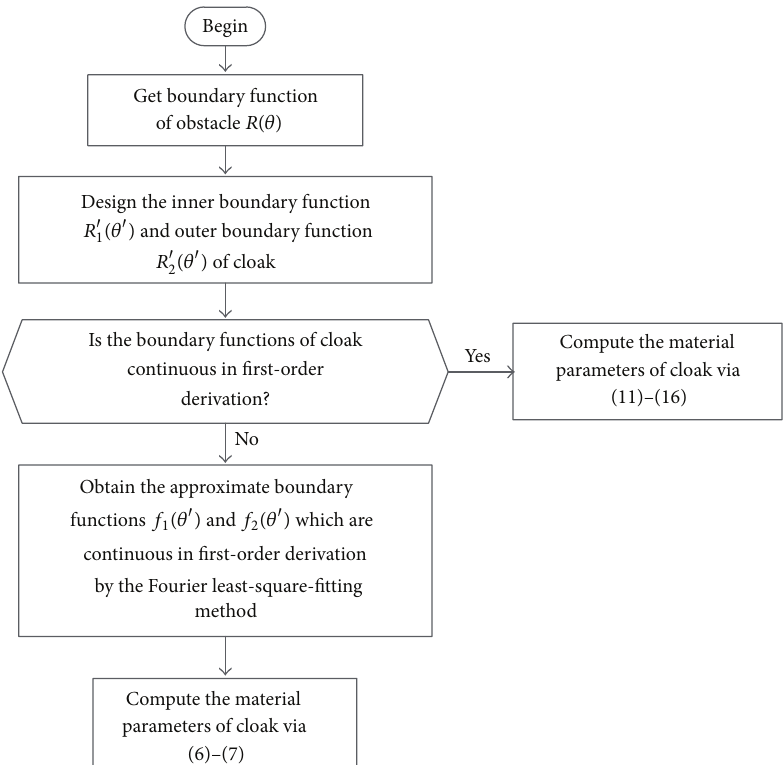
Figure 5: The calculation flowchart of the material parameters for the cloak.